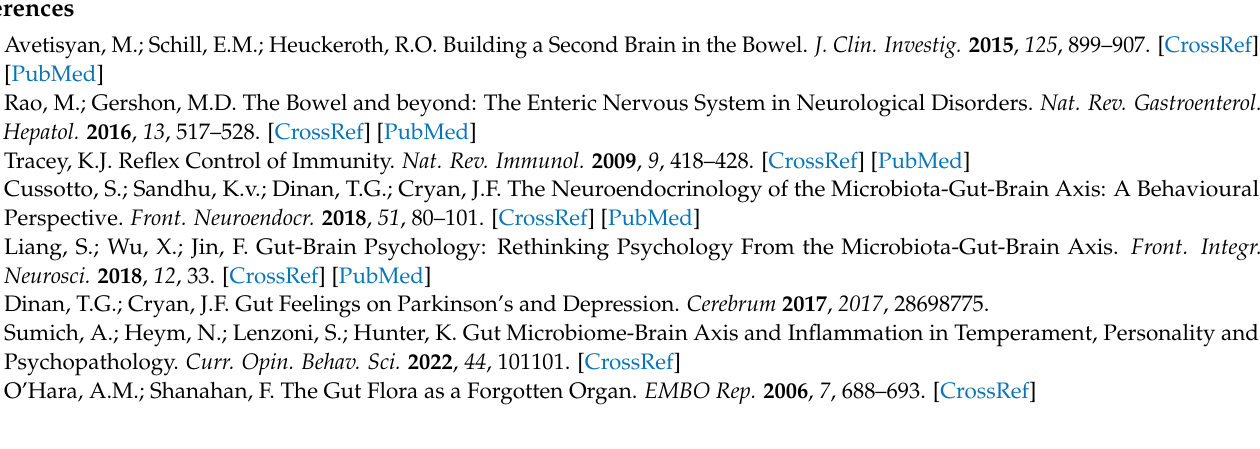
Figure S10: Microscopic comparison of mature Caco2Bbe1 cells on day-21 in the fully developed